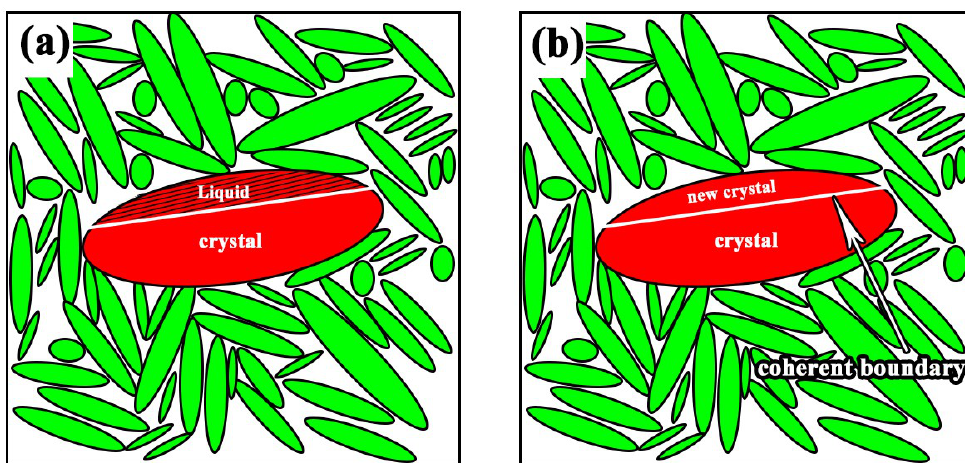
Figure 12. Schematic illustration of grain boundary nucleation. ( a ) Nucleation period; ( b ) Crystal growth period.